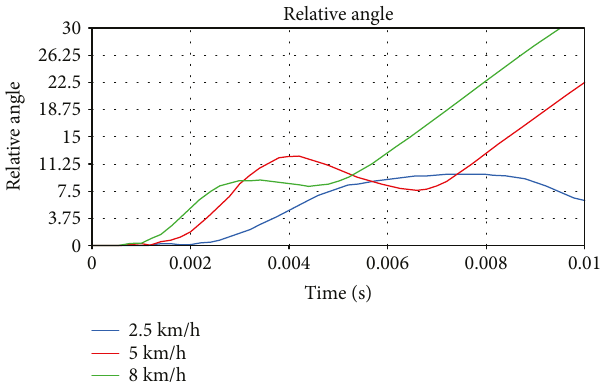
Figure 8: Curves of the varus angle at di ff erent impact speeds.